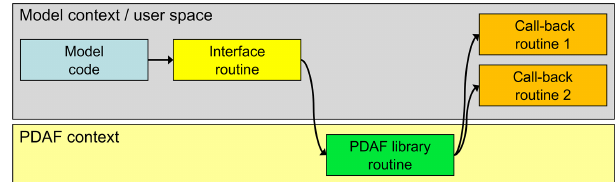
Figure 1. Call structure of PDAF. Calls to interface routines (yel- low) are inserted into the model code (blue). The interface rou- tines define parameters for PDAF and call PDAF library routines (green). These library routines call user-provided call-back routines. The model code, interface, and call-back routines operate in the model context and can hence exchange information indirectly, e.g., through Fortran modules. Likewise, the PDAF library routines share